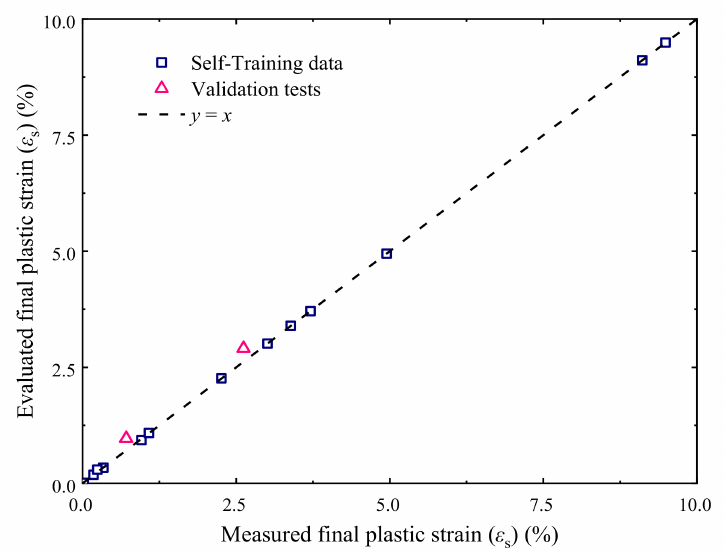
Figure 13. Output of ε s using the optimal BP neural network.